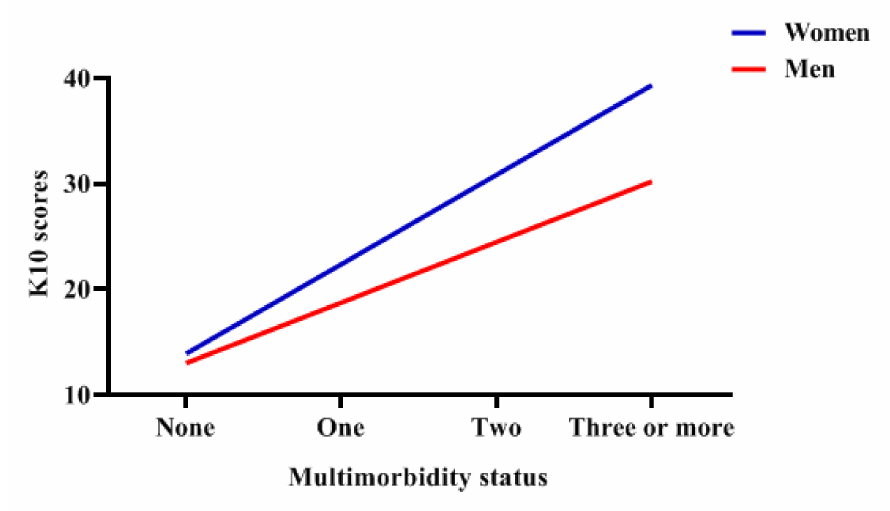
Figure 2. The role of gender among the association between multimorbidity status and mental